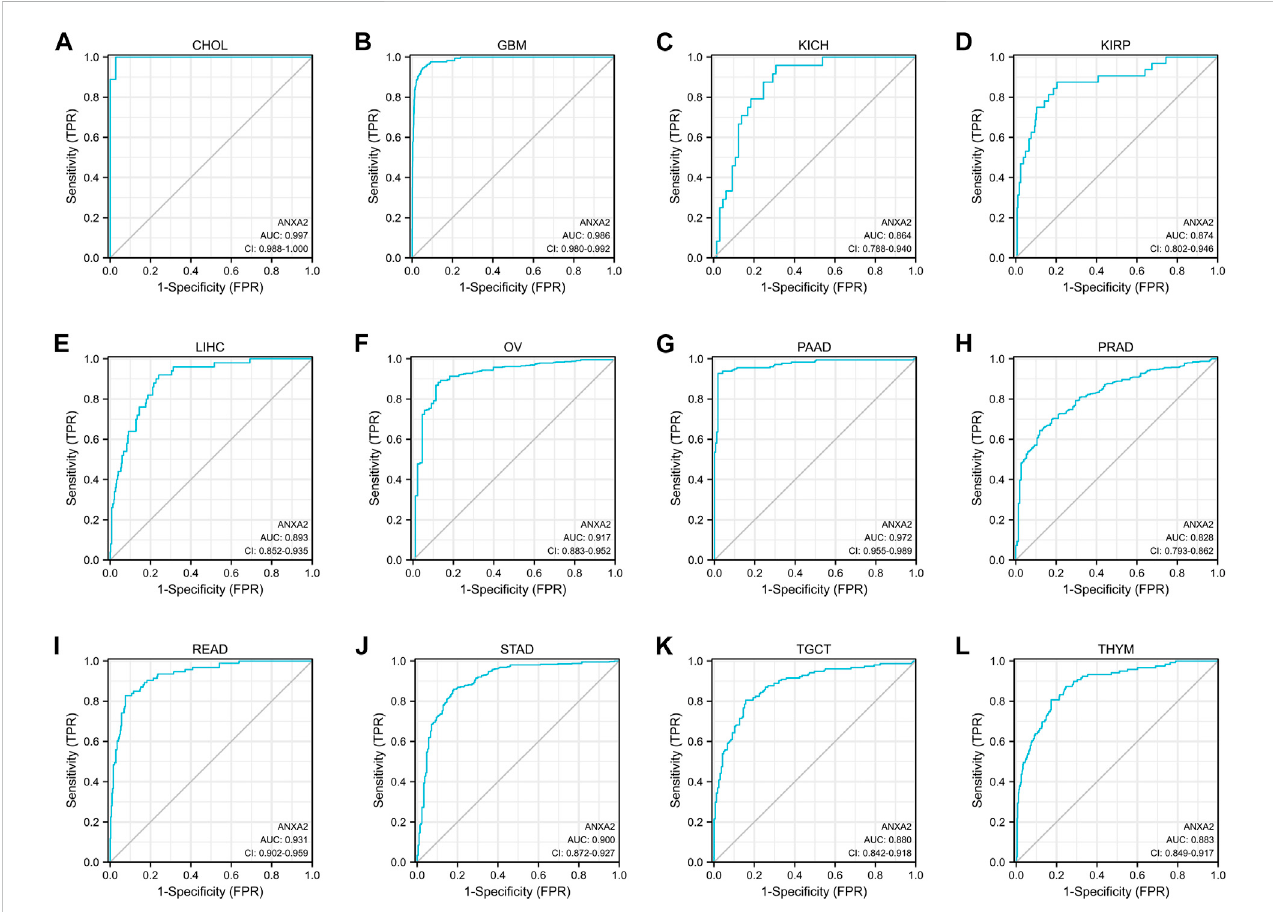
FIGURE 3 The area under the curve of ROC curves veri fi ed the diagnostic ability of ANXA2 in (A – L) CHOL, GBM, KICH, KIRP, LIHC, OV, PAAD, PRAD, READ, STAD, TGCT and THYM.